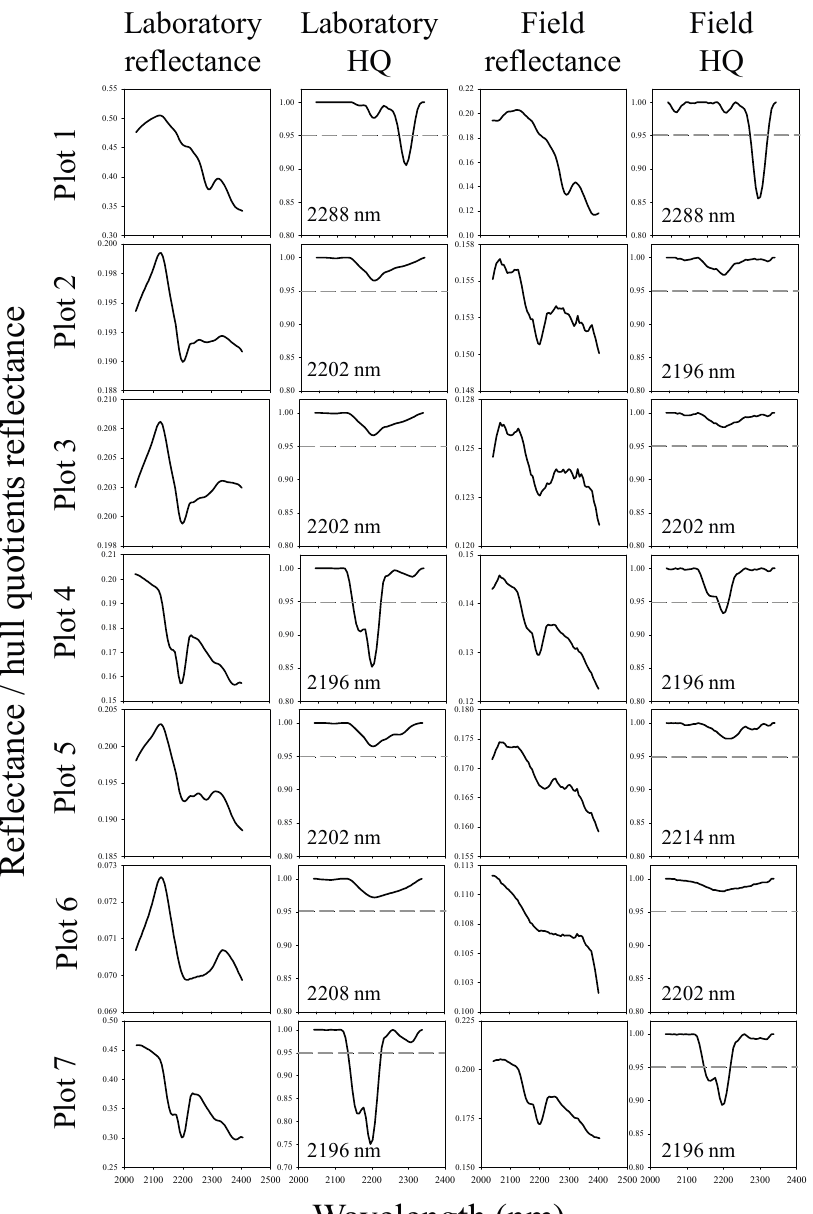
Figure 9. Reflectance (1998–2404 nm) and hull-quotients (HQ; 2041–2337 nm) spectra from hyperspectral imagery acquired in the laboratory and in the field. Spectra acquired in the laboratory are average spectra from the rock samples acquired from the mine face ( n = 1000). Spectra acquired in the field are average spectra for pixels over each sampled plot in the imagery ( n = 224). See Figure 1 for locations of Plots). Note that the hull quotients spectra have been constrained to the spectral region over which the continuum was removed prior to AFE (2041–2337 nm). The broken horizontal line in the hull-quotients plots is the threshold; only features which extend below this line were considered for parameterization by AFE (see text for